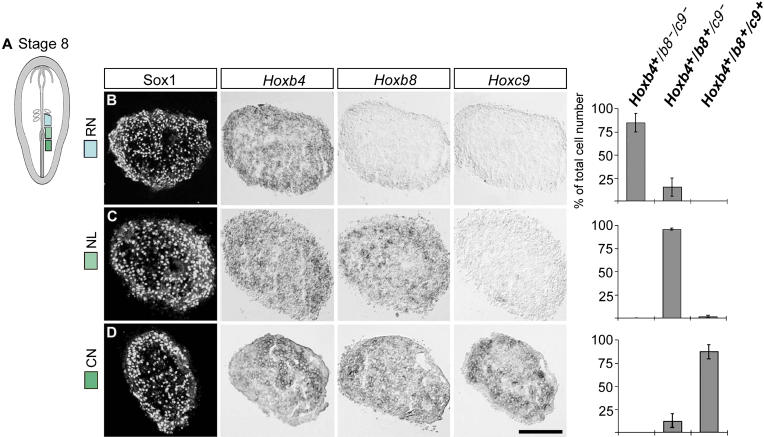
Hindbrain and Spinal Cord Progenitor Cells Acquire Rostrocaudal Regional Identity at the Early Somite Stage(A) Schematic drawing of a stage 8 chick embryo. The boxed regions indicate neural plate explants cultured in vitro for 40 h.(B–D) Sox1 was used as a general neural marker. Bars represent mean ± s.e.m. number of cells in
Hoxb4
+/

b8
−/c9
−,

Hoxb4
+/b8
+/

c9
−,
 and
Hoxb4
+/b8
+/c9
+ domains, respectively, as percentage of total cell number. Each row represents consecutive sections from a single explant.
(B) Explants isolated from the RN generated
Hoxb4
+/

b8
−/c9
− cells and few
Hoxb4
+/b8
+/
c9
− cells (
n = 8 explants).
(C) Explants isolated at the NL generated
Hoxb4
+/b8
+/

c9
− cells (
n = 15 explants).
(D) Explants isolated from the CN generated
Hoxb4
+/b8
+/c9
+ and only a few
Hoxb4
+/b8
+/

c9
− cells (
n = 12 explants). Scale bar represents 100 μm.